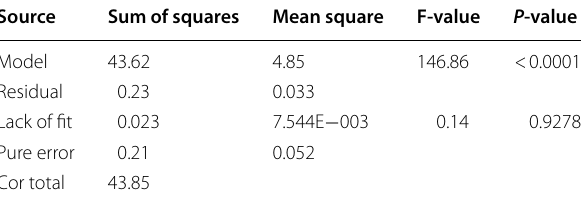
Table 5 Analysis of variance for quadratic model of xylooligosaccharide production from